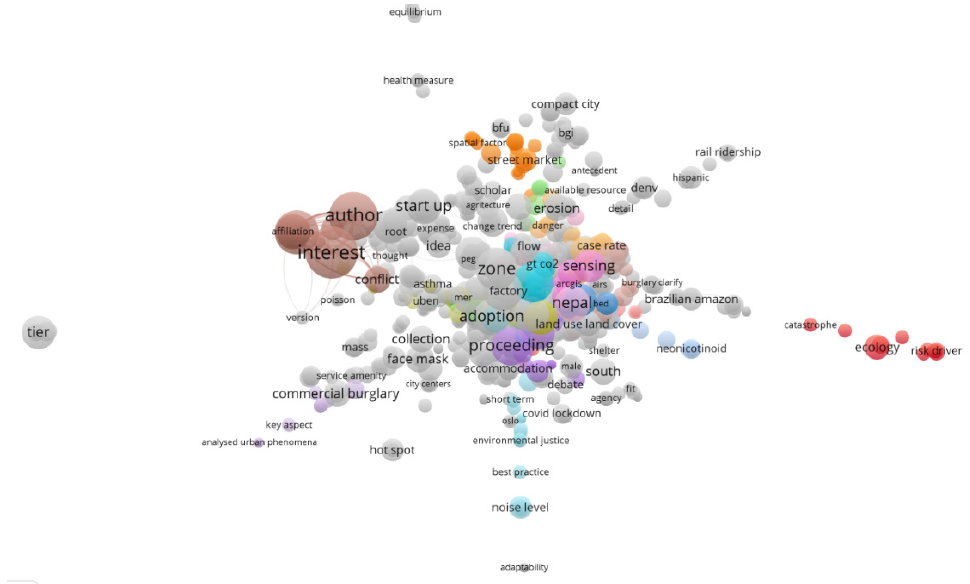
Figure 6. Network visualization map constructed from text data, considering terms as items, for the topics “COVID-19” and “land use”, applying full counting with 1 as the minimum number of occurrence of a term.